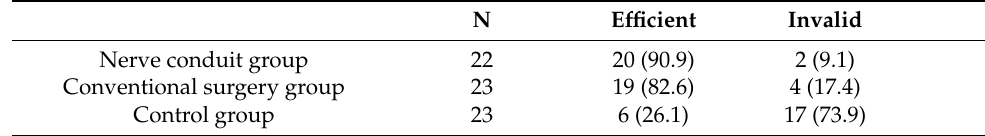
Table 2. Comparison of the curative effect among the three groups [n (%)].